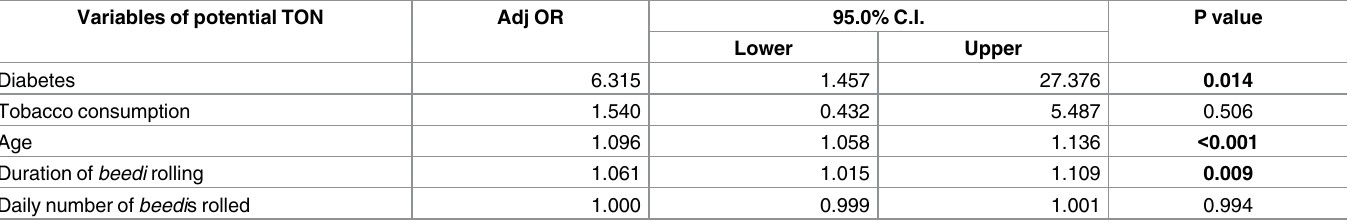
Table 4. Multiple logistic regression analysis for various factors associatedwith potential toxic optic neuropathy among beedi rollers in selected rural areasof Dakshina Kannada district, Karnataka,India, April-Sept 2016 (N = 365). Variables of potential TON